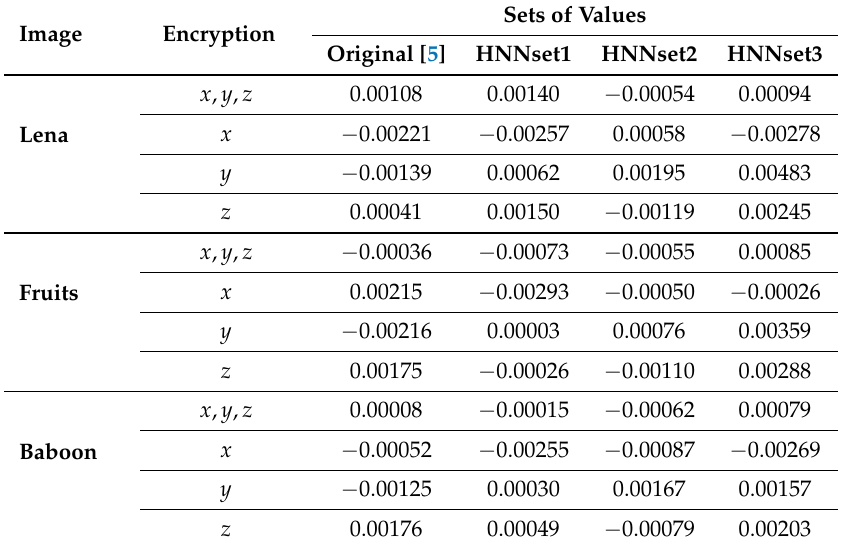
Table 10. Correlations between the chaotic channel and the RGB Lena, Fruits and Baboon images using the sequences generated by the Hopfield neuron for the state variables x , y , and z